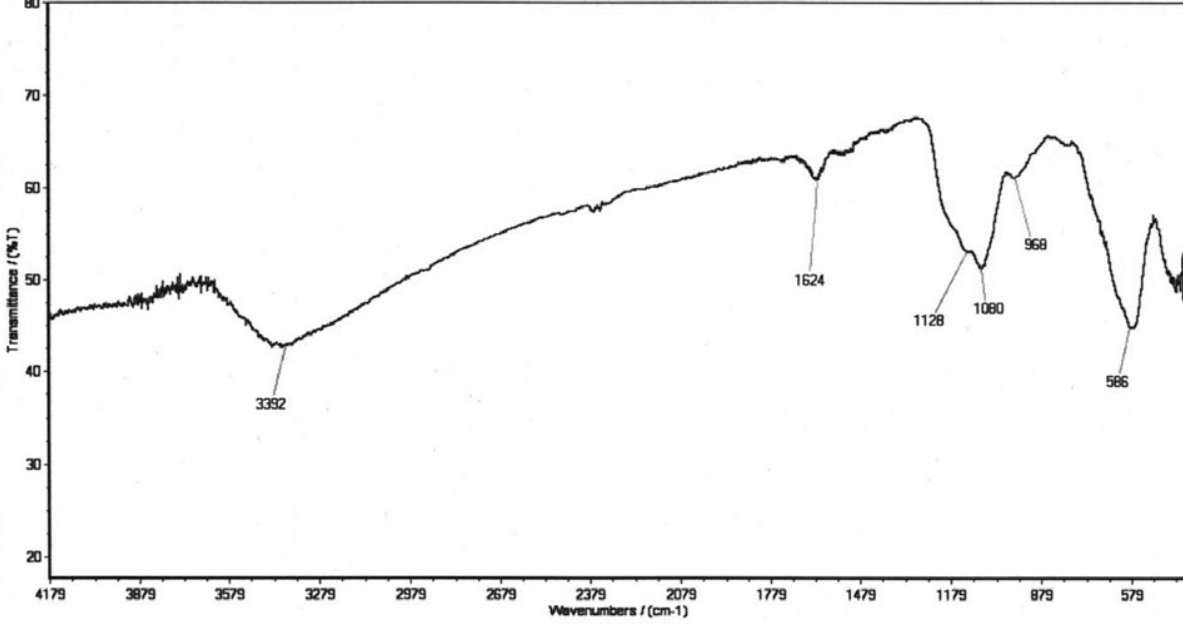
O @SiO -OSO H nanocomposite 3 4 2 3